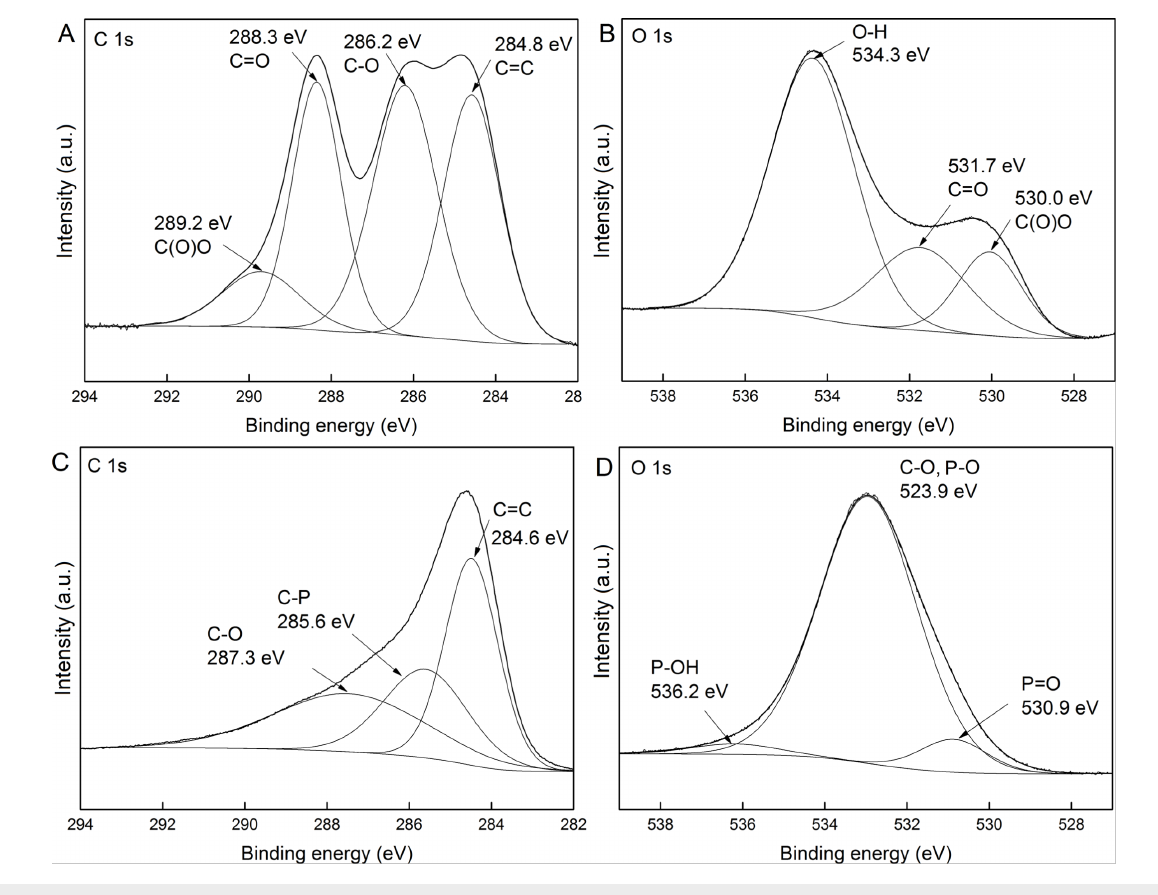
as C 1s, indicate a variety of oxygen functionalities in the analyzed sample, including hydroxy, carboxyl and epoxide groups. In the case of the GO-P sample, the peaks referring to covalent carbon–oxygen bonds are reduced in their intensity